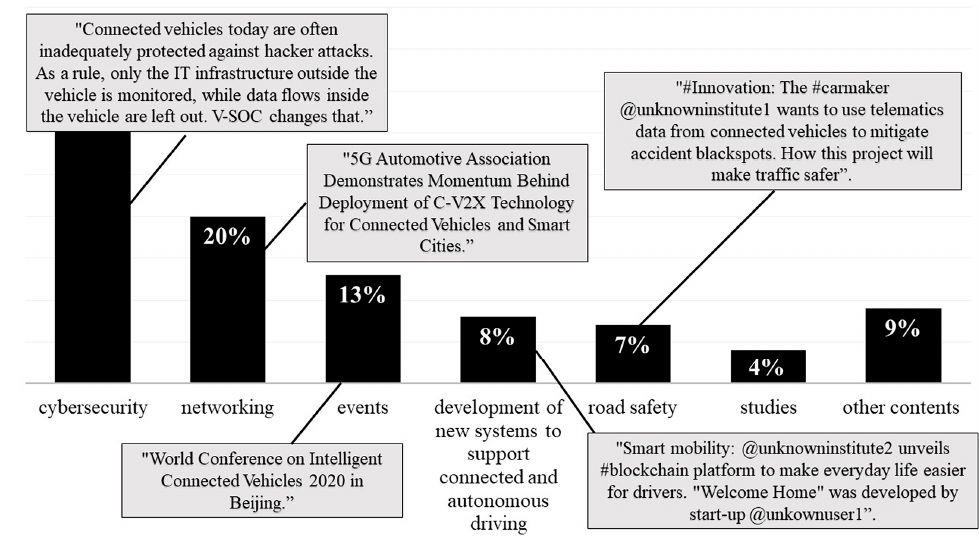
Figure 6. Topic distribution and example tweets in the category CC: News/Information.